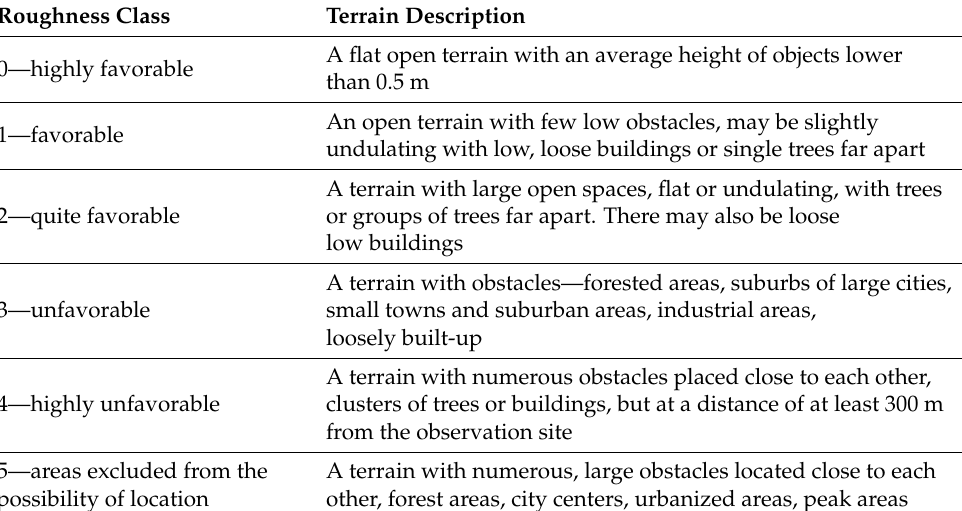
Table 6. Assessment of the roughness class of the terrain with regard to the possibility of using wind